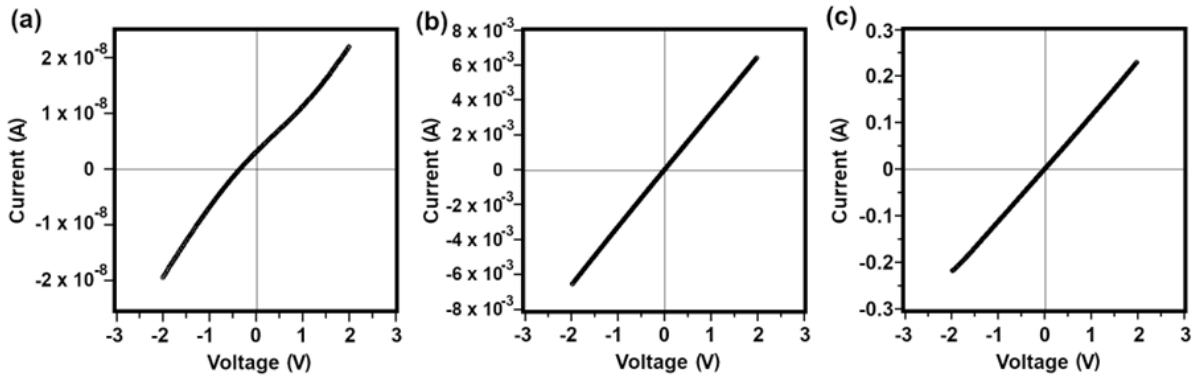
Figure 3. Voltage (V) × current (A) plots for the graphene samples: ( a ) GO1, ( b ) rGO1 and ( c ) EG.